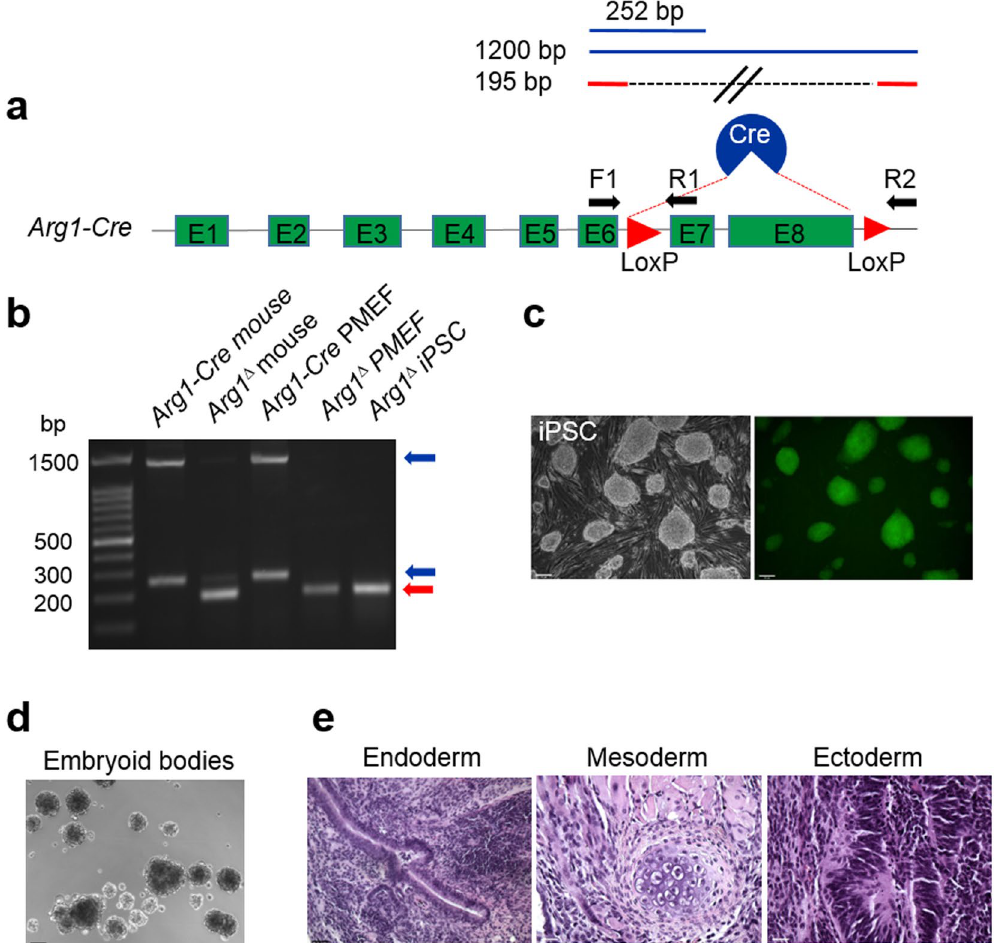
Figure 1. Generation of Arg1-deficient iPSCs from PMEF cultures. ( a ) Schematic diagram depicting the genotype of cell source. The arrows indicate the positions of the primers used for genotyping the resulting cells. ( b ) PCR genotyping to confirm the deletion of exons 7 and 8. Arg1 - Cre PMEFs showed bands at 1.2 kb and 252 bp (indicative of intact exons 7 and 8), while both Arg1 ∆ PMEFs and derived iPSCs produced only one band at 195 bp. Skin fibroblasts isolated from a tamoxifen-induced Arg1-deficient mouse were used as a positive control, while untreated Arg1-Cre PMEFs served as negative control. ( c ) Alkaline phosphatase as a pluripotent marker. ( d ) Formation of embryoid bodies and ( e ) teratoma assay to demonstrate trilineage differentiation in vitro and in vivo , respectively. Shown are gutlike epithelial tissues, cartilage and neural tissues, depicting the formation of endoderm, mesoderm and ectoderm,